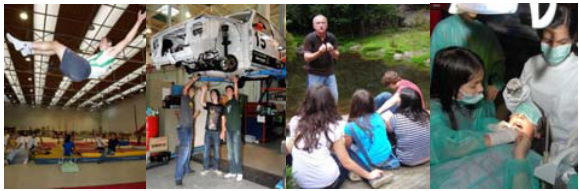
Figure 2. UJr activities in sport, mechanical engineering, biology and dental medicine TABLE I. S UMMER E XPERIENCES SAMPLE WEEK PROGRAM ( ONE OF FIVE )